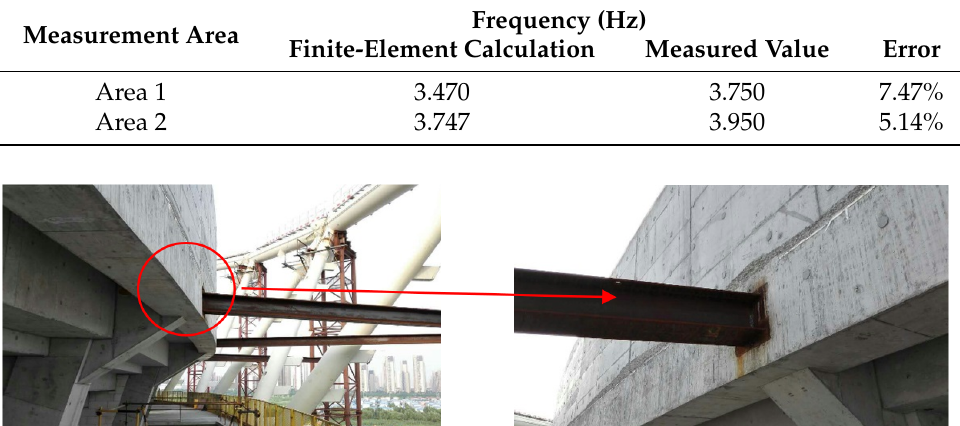
Table 6. Comparison of calculated and measured values of first-order vertical frequency.